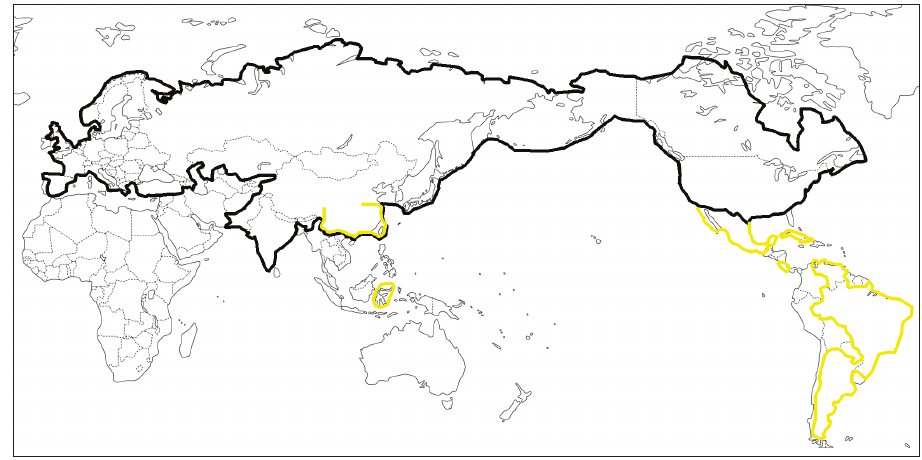
Figure 26. Distribution of predominantly black and predominantly yellow species of Apechthis at the country scale, based on Yu et al. (2012). Note that some countries or regions which have no recorded Ape- chthis are included in the distribution ranges for convenience, based on records from adjacent